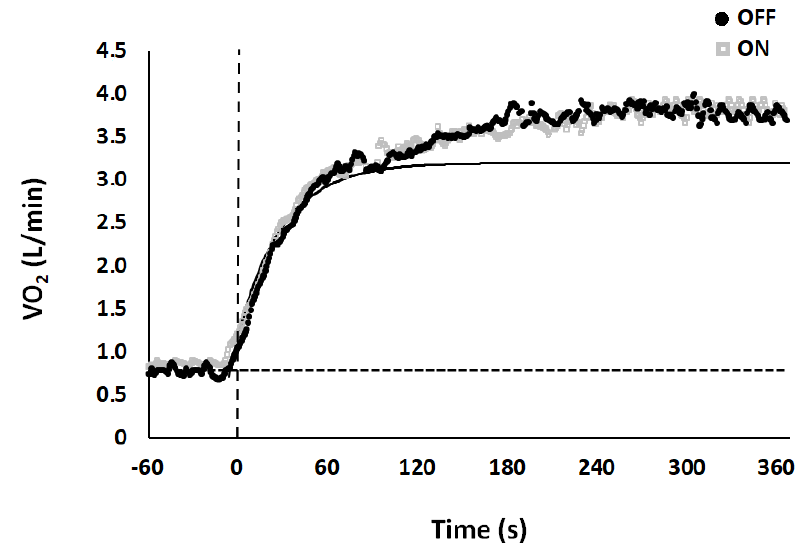
Figure 1. Model fit for VO 2 kinetics between conditions, OFF (black dot) and ON (grey square) for a typical subject. Vertical dotted line at time 0 represents the transition from unloaded cycling (baseline) to constant load exercise. Horizontal dashed line represents the baseline. Data points are average values calculated each second.